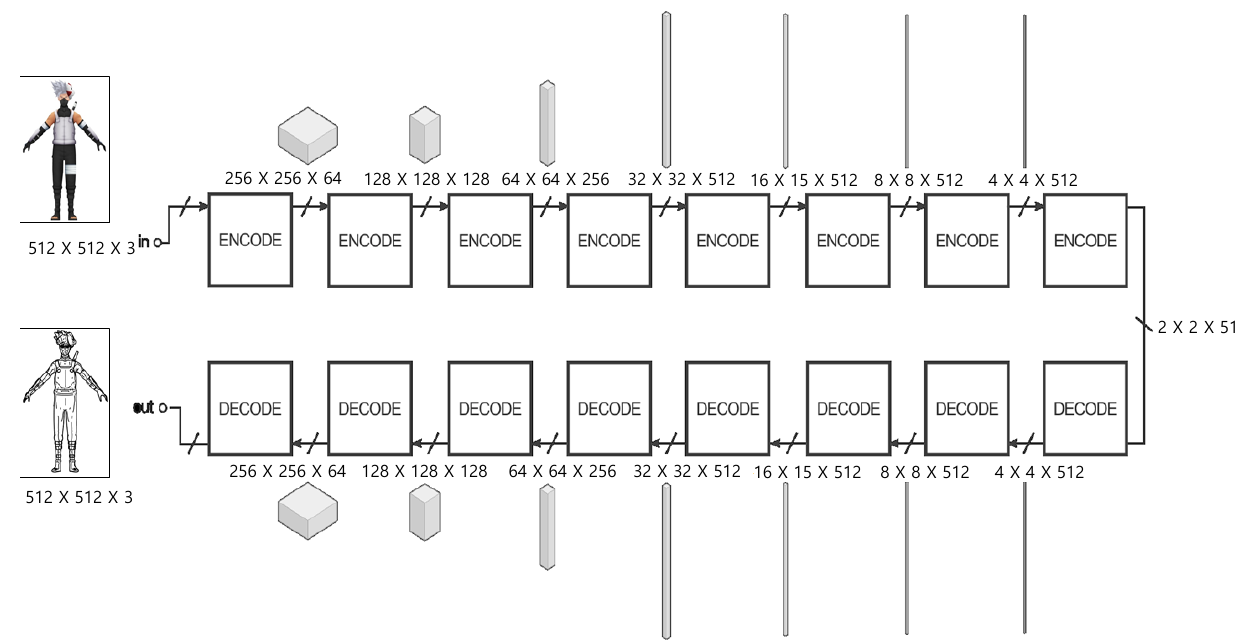
Figure 8. The structure of the generator.